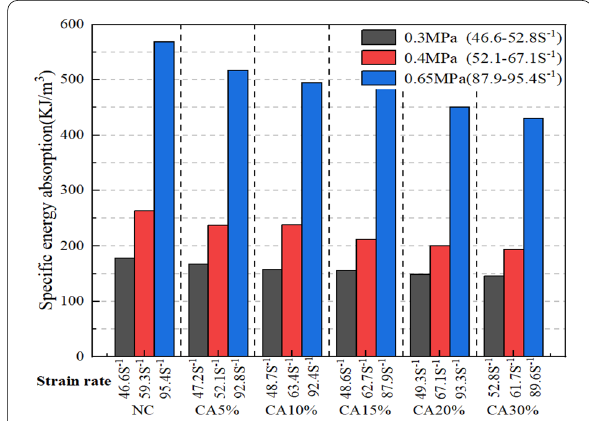
Fig. 16 Specific energy absorption value.